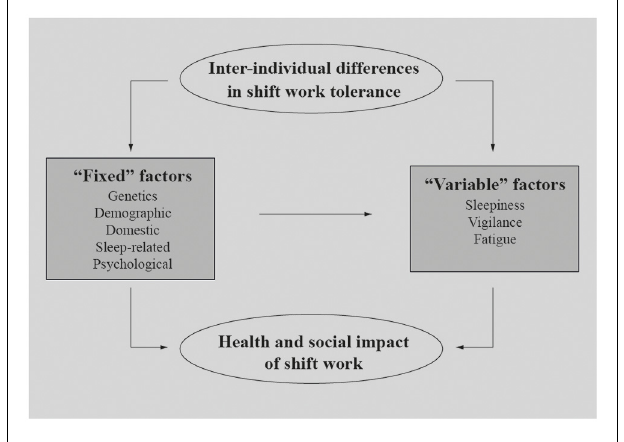
FIGURE 1 | “Fixed” and “Variable” inter-individual factors potentially explaining health and social impact of night shift work on nurses. a protective factor (Bonnefond et al., 2006), probably thanks to improved coping strategies over time (Øyane et al.,